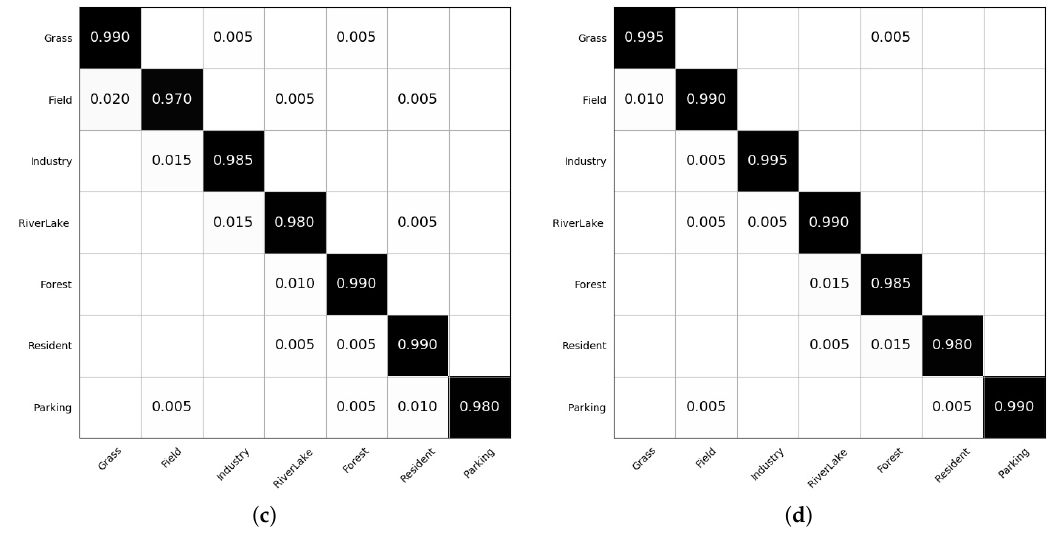
Figure 10. Confusion matrix of ( a ) OSELM; ( b ) Pegasos; ( c ) Perceptron and ( d ) Ramp data